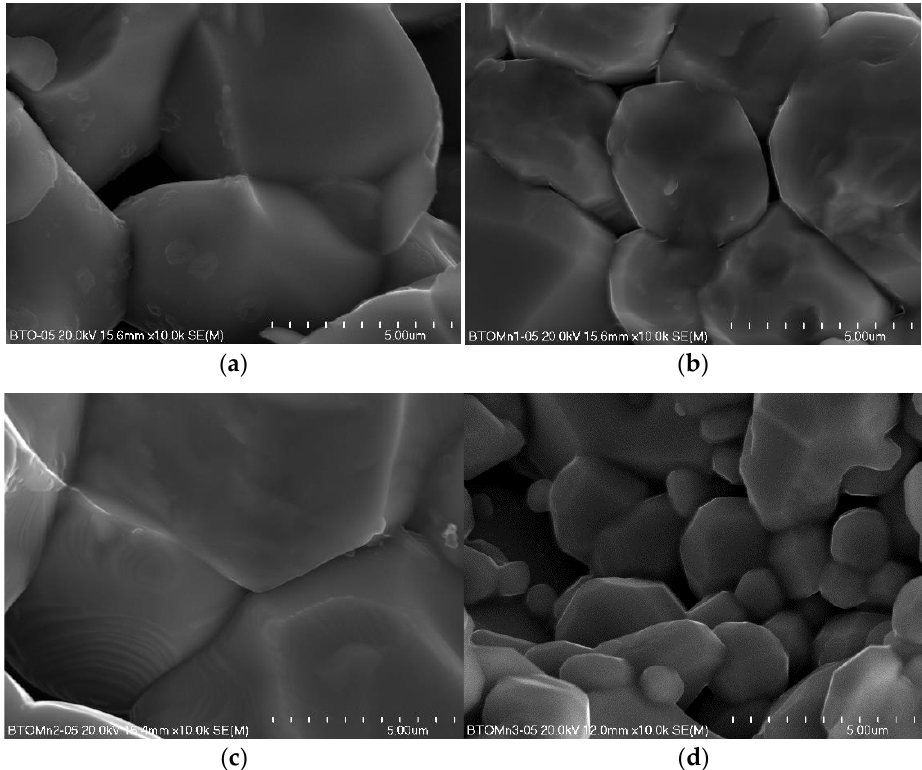
Figure 1. SEM images of ceramic BaTiO 3 ( a ), BTO_1 ( b ), BTO_2 ( c ), and BTO_3 ( d ) (magnification 10,000×).